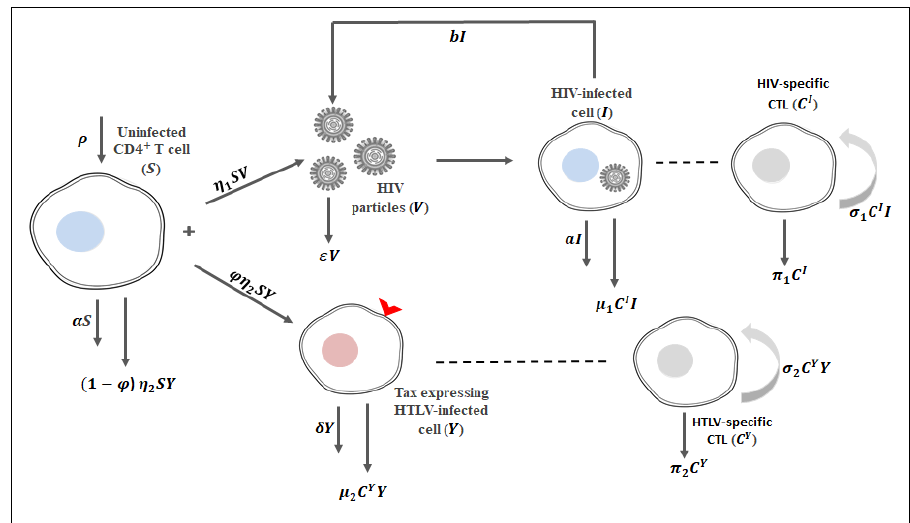
Figure 1. The schematic diagram of the HTLV/HIV dual infection dynamics in